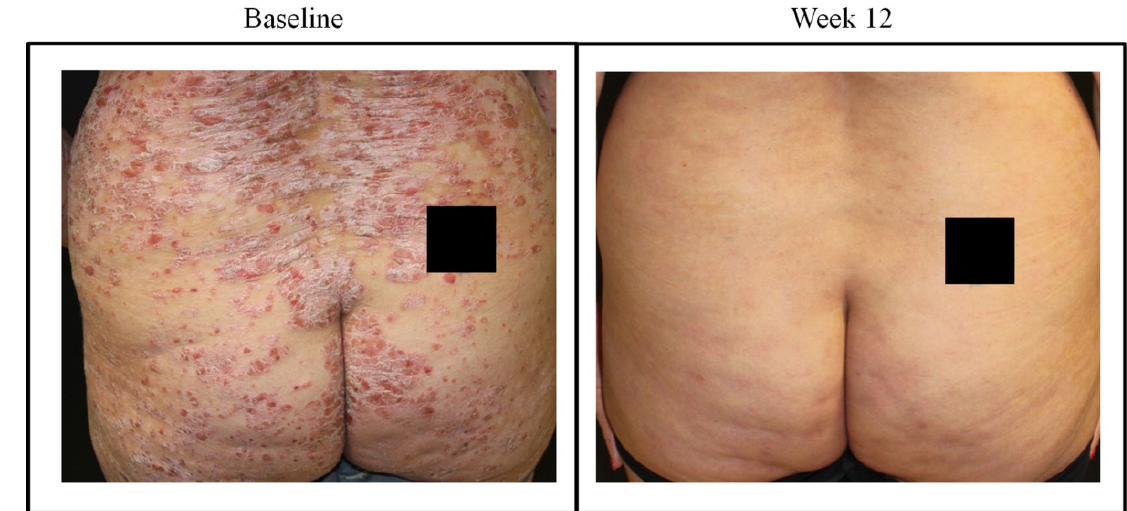
Figure 4. Representative images of outcome at the gluteal region in case #1; a female patient, aged 52 years with onset of psoriasis at 47 years of age. At baseline, PASI was 44.4 and VAS pain was 80. After 12 weeks with guselkumab (induction phase: 100 mg subcutaneously at weeks 0 and 4, and a maintenance dose every 8 weeks thereafter), PASI decreased to 3 and VAS pain was 30.